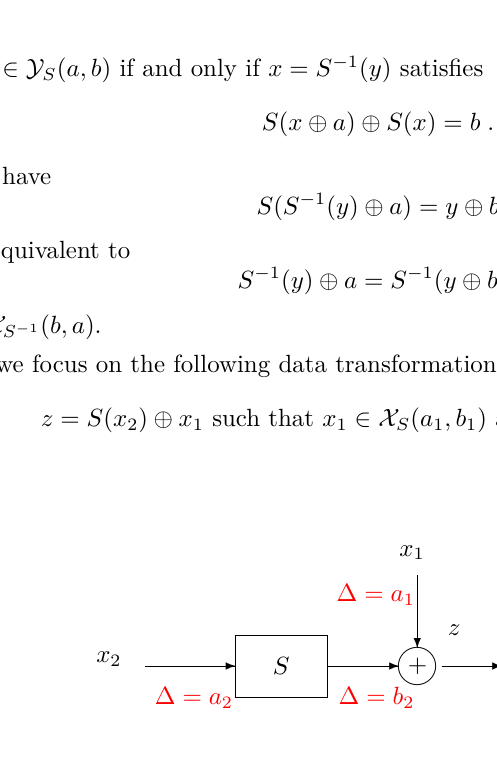
Figure 2: Target